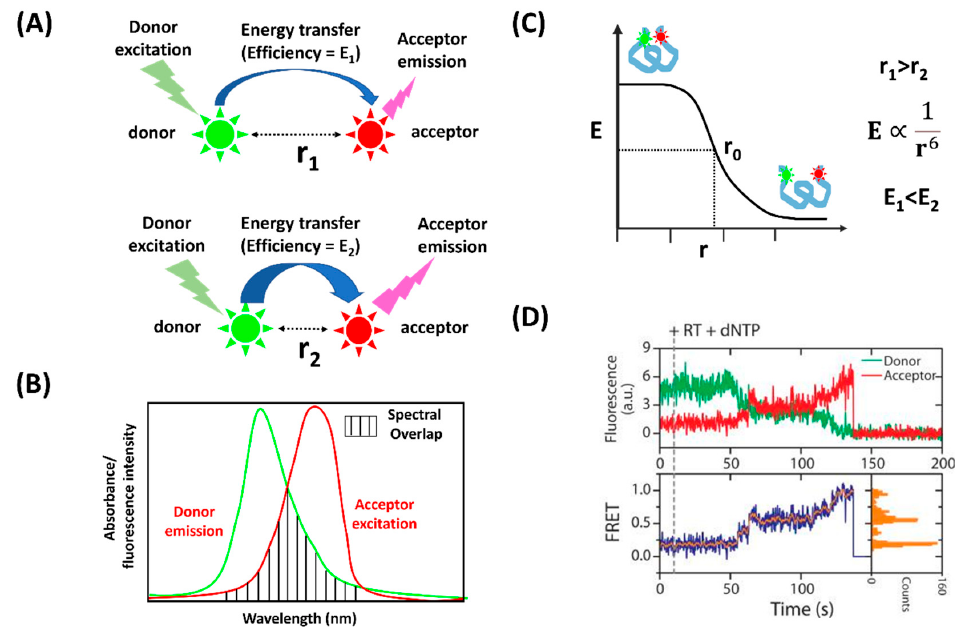
Figure 1. ( A ) Schematic of energy transfer from a donor (green star) to an acceptor (red star). The transfer efficiency depends on the distance (r) between the donor and the acceptor. In the top panel, the donor and the acceptor are further apart than they are in the bottom panel. This results in a much lower value of E for the top panel. ( B ) The spectral overlap (shaded region) between the donor emission and the acceptor absorption. The higher the overlap, the higher the efficiency of energy transfer. ( C ) The dependence of E on distance (r) between two fluorophores labeled on a macromolecule (blue ribbon structure). r 0 denotes the distance at which 50% energy transfer happens. ( D ) Real-time FRET traces from reference [17] (Liu, S.; Abbondanzieri, E.A.; Rausch, J.W.; Le Grice, S.F.J.; Zhuang, X. Slide into action: dynamic shuttling of HIV reverse transcriptase on nucleic acid substrates. Science (New York, N.Y.) 2008 , 322 , 1092–1097, doi:10.1126/science.1163108.) with permission. The work involves unzipping of the non-template strand of RNA (labeled with the donor) from the template strand (labeled with the acceptor). Upper panel shows donor (I D , green) and acceptor (I a , red) emissions. The bottom panel shows the FRET efficiency (blue) calculated using the equation E = I A /(I D + I A ). On the right is the histogram showing population corresponding to the specific value of E.